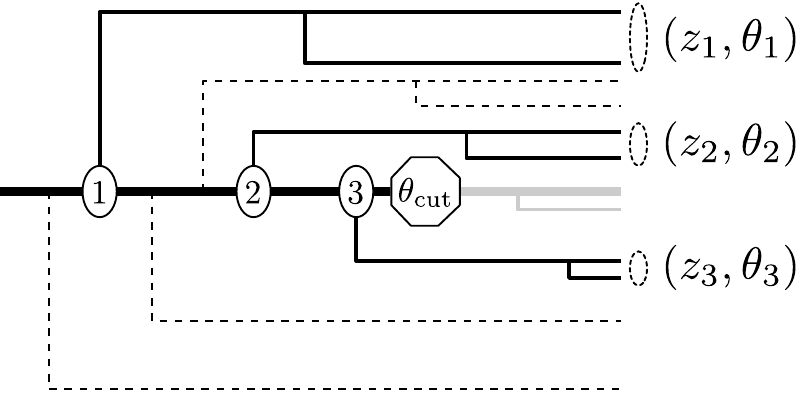
Figure 1. Illustration of the ISD procedure. A C/A tree is declustered from the trunk (thick line), de(cid:12)ned by the hardest p T branches. If a node fails the soft drop condition, it is removed from consideration (dashed lines). If a node passes the soft drop condition after n iterations, this de(cid:12)nes the value of ( z n ; (cid:18) n ). The declustering stops at an angular scale of (cid:18) cut , and subsequent nodes are not considered further (gray